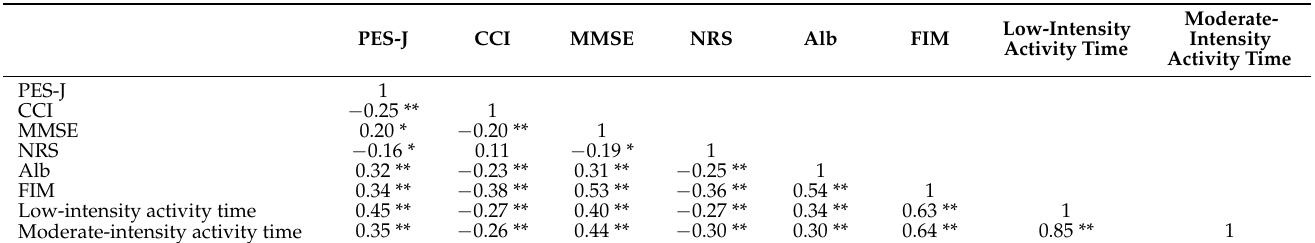
Table 4. Correlation matrix of continuous variables analyzed in the structural equation modeling (N =